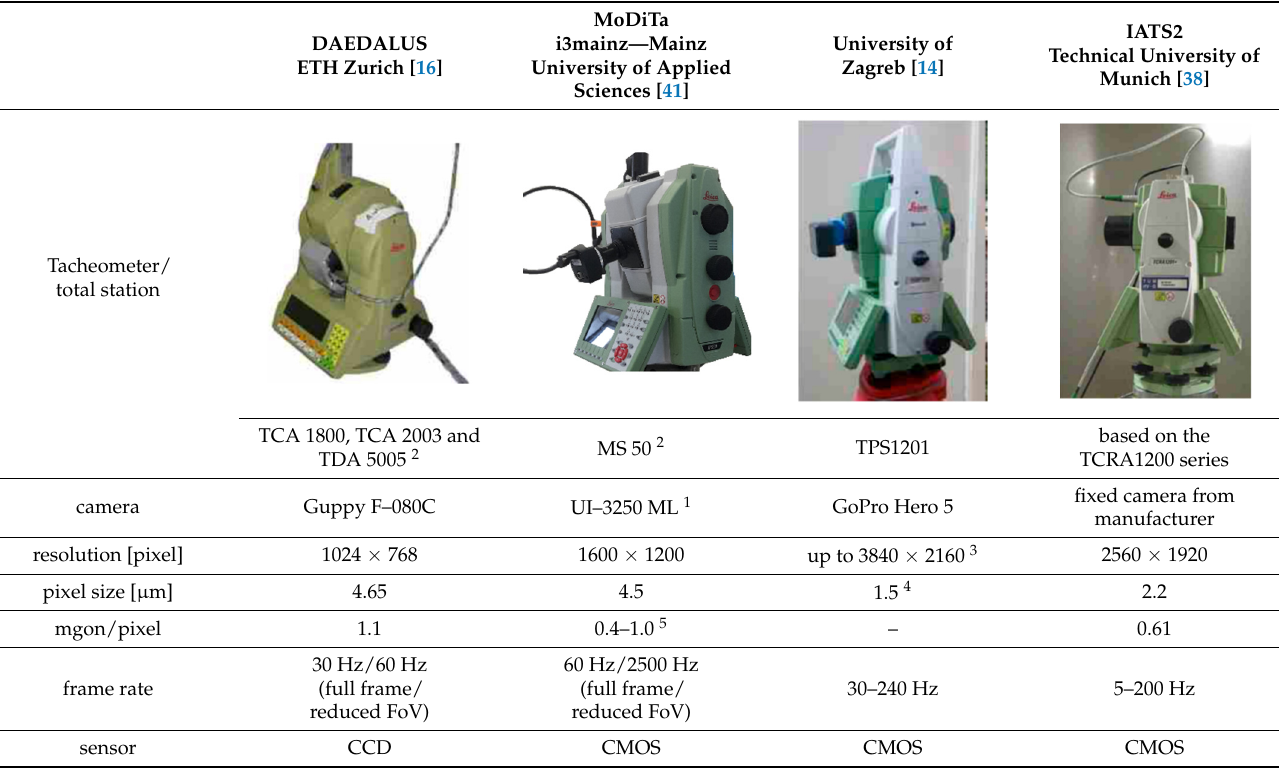
Table 1. Main specifications and set-up of IATS prototypes mentioned in [14,16,38,41].